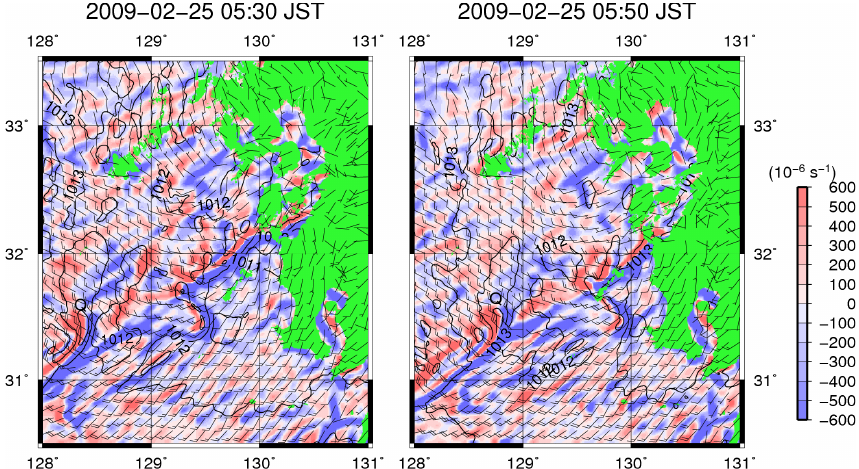
Fig. 14. Similar to Fig. 13, but the plotted area is limited to the coastal area of western Kyushu.